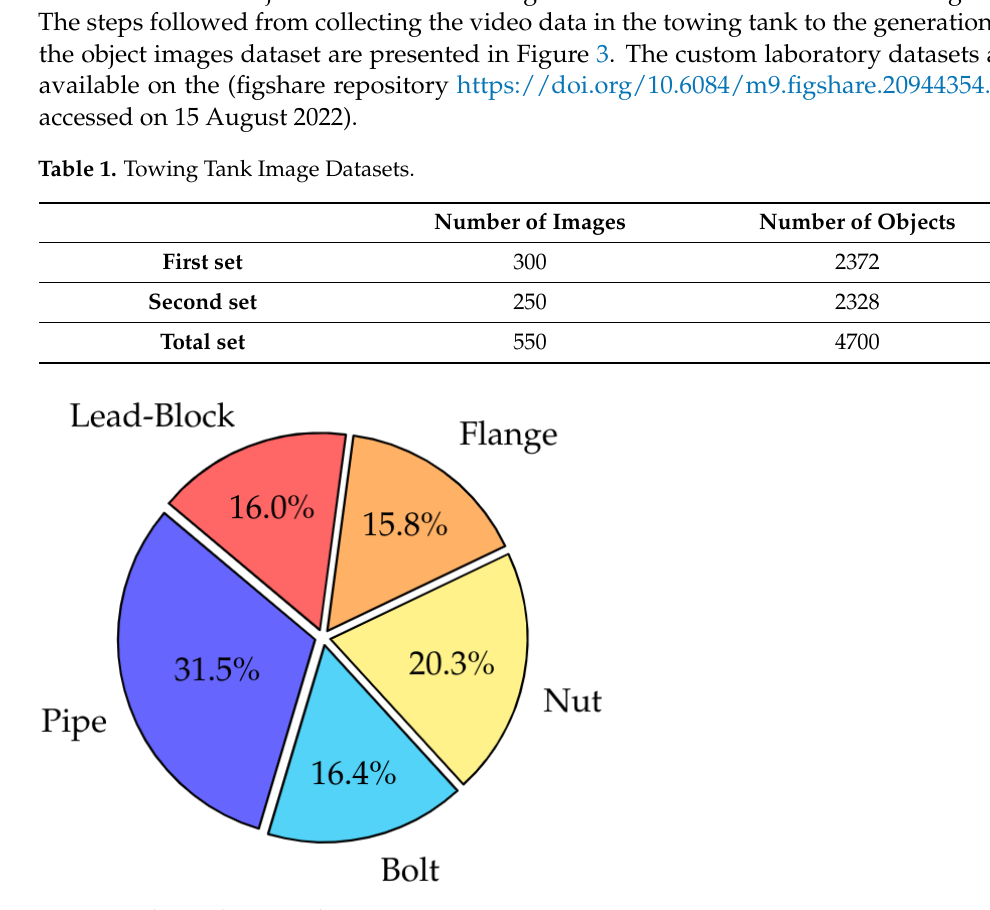
Figure 2. Object Class